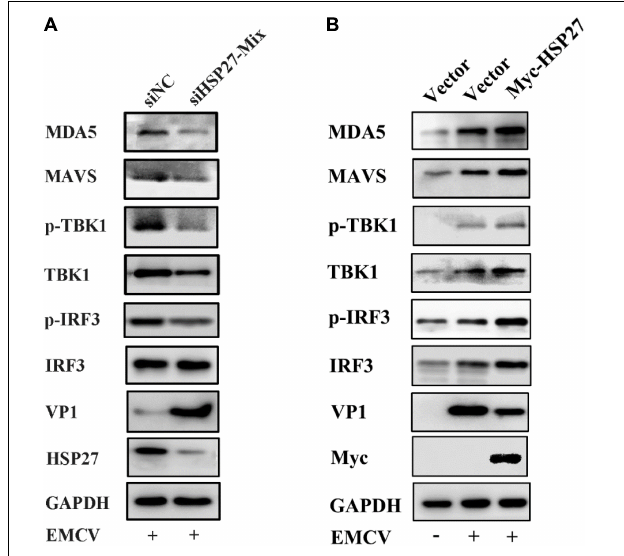
FIGURE 6 | HSP27 enhances encephalomyocarditis virus (EMCV)-triggered RIG-I-like receptor (RLR)/melanoma differentiation-associated gene 5 (MDA5) signaling pathway. (A) A549 cells were transfected with either 150 nmol of siHSP27-Mix or siNC for 36 h before infecting with EMCV at an multiplicity of infection (MOI) of 0.01 for 36 h. The protein expression of MDA5, MAVS, TBK1, p-TBK1, IRF3, p-IRF3, HSP27, and VP1 were analyzed by immunoblotting. GAPDH was used as a loading control. (B) A549 cells were transfected with pCMV-Myc or Myc-HSP27 (0.5 µ g) for 24 h before infecting with EMCV at an MOI of 0.01 for 36 h. The protein expression of MDA5, MAVS, TBK1, p-TBK1, IRF3, p-IRF3, Myc, and VP1 were analyzed by immunoblotting. GAPDH was used as a loading control.